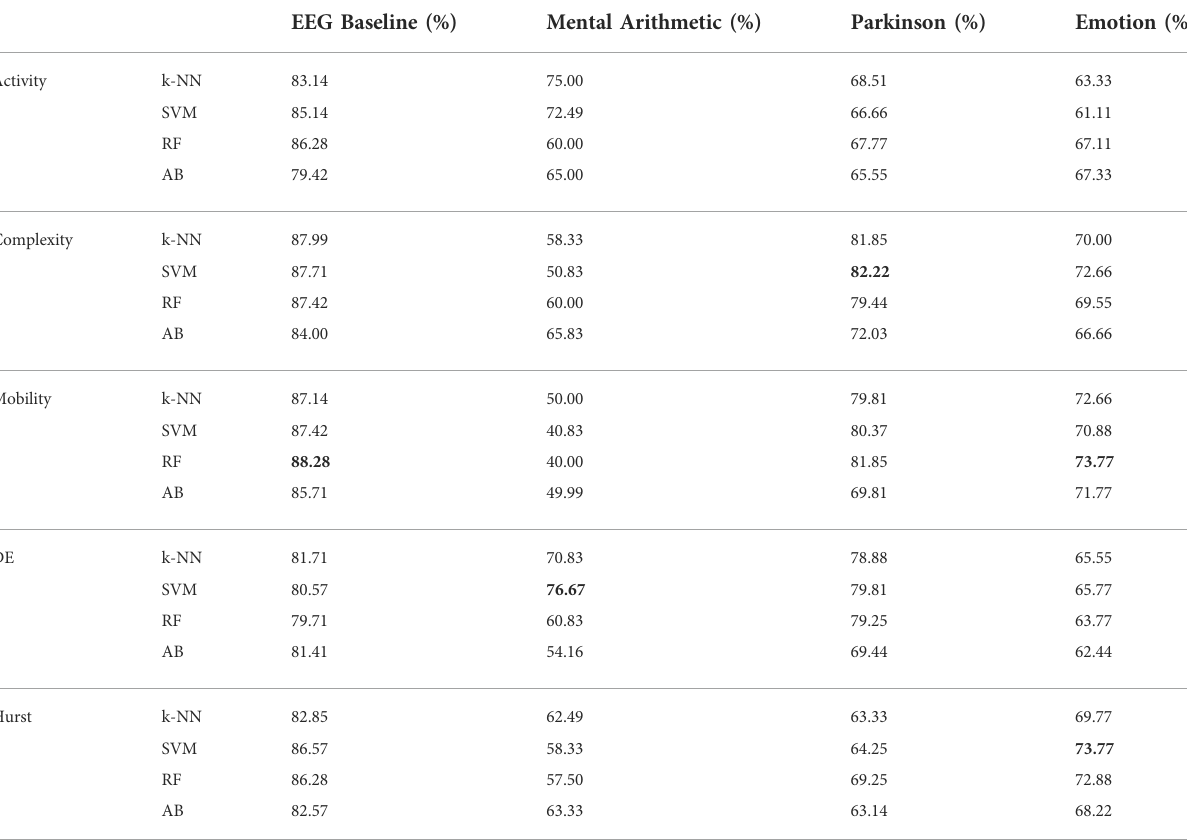
TABLE 2 Mean accuracies obtained for 1D non-linear feature vectors trained using traditional